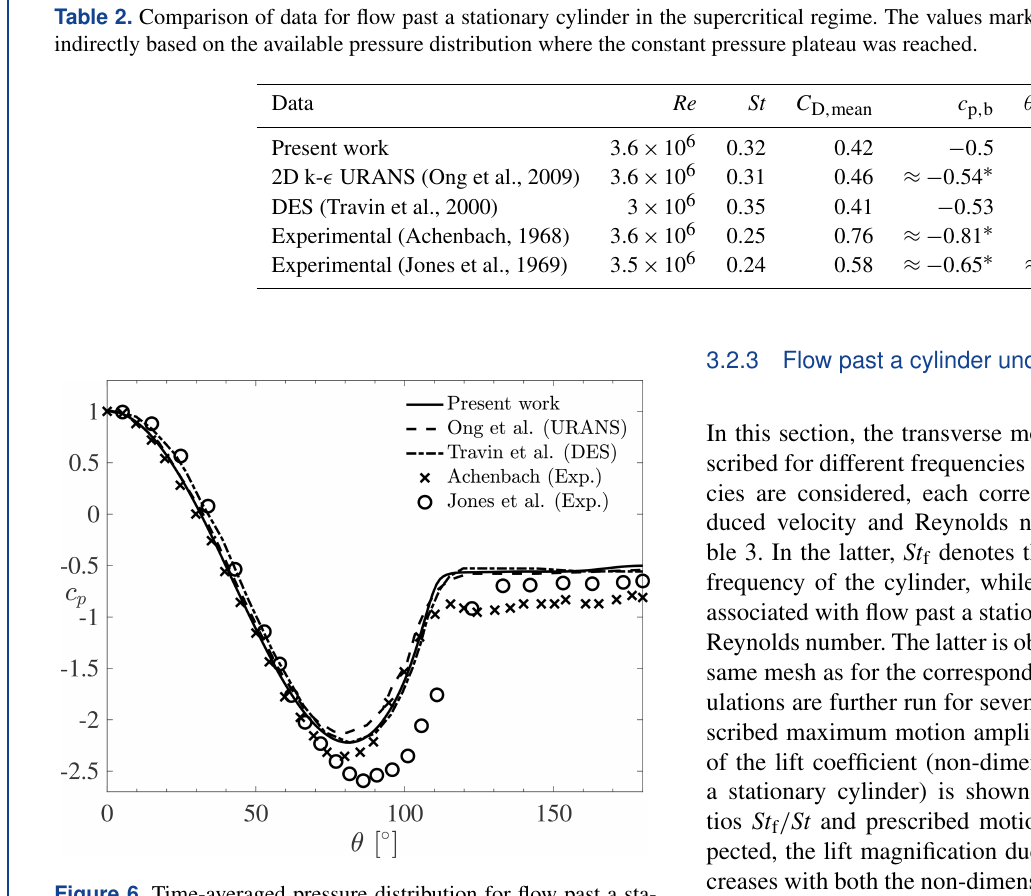
Figure 6. Time-averaged pressure distribution for flow past a sta- tionary cylinder in the supercritical turbulent regime.